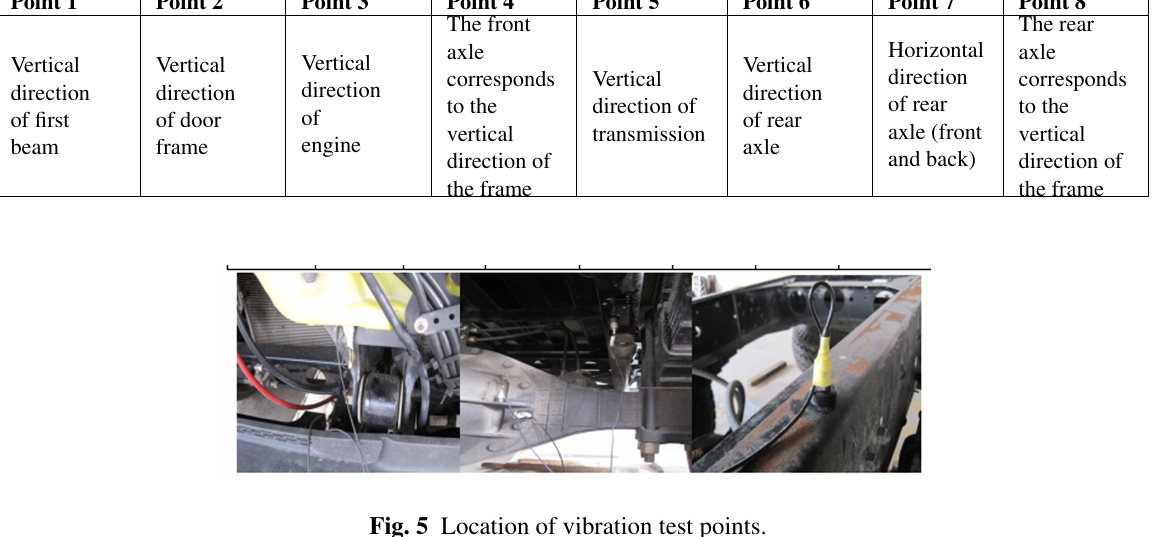
Fig. 5 Location of vibration test